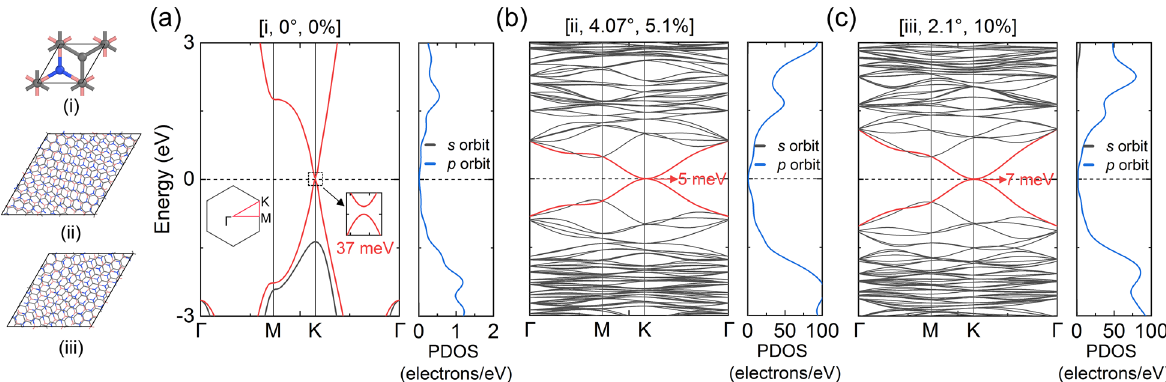
Figure 5. Heterostrain-modulated energy bands and partial densities of state (PDOS). Left panel: (i), (ii), and (iii) present the bilayer supercells of [ θ = 0 ◦ , ε b = 0% ] , [4.07°, 5.1%], and [2.1°, 10%] in Fig. 3a,b (see magenta arrows) with 10, 362, and 284 atoms in the supercells, respectively. Corresponding results are shown in ( a – c ). Inset in ( a ) outlines the integration path in the first Brillouin zone. Horizontal dotted lines indicate the Fermi level. Red curves mark the valence band maximum and the conduction band minimum, which determine the band gap. In each PDOS, the contribution of s orbits is too small to be